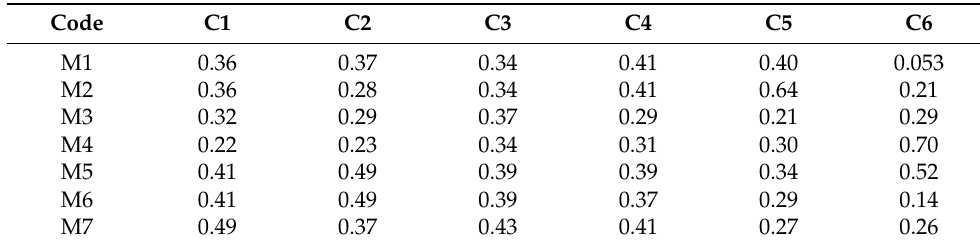
Table 8. Normalized matrix VIKOR(Rij).